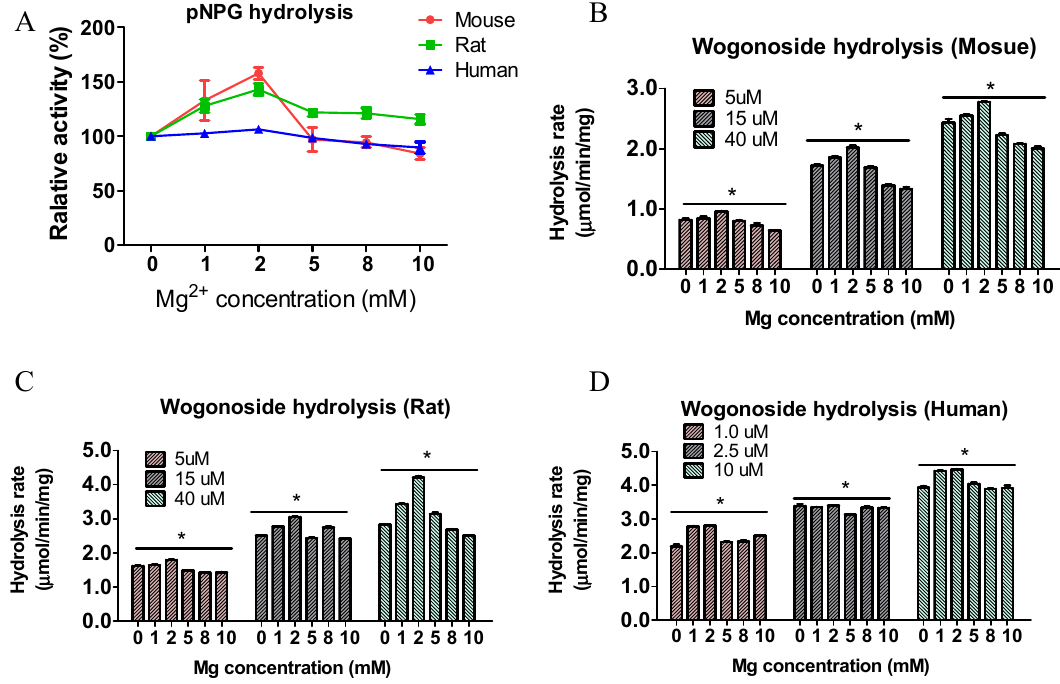
Figure 5. Impact of Mg 2+ on pNPG ( A ) and wogonoside hydrolysis ( B , mouse, C , Rat, D , Human). The pNPG (final concentration, 1 mM) or wogonoside was incubated with the enzymes in the buffers containing different concentrations of Mg 2+ for 30 min at 37 °C (n = 3, * p < 0.05, One-Way ANOVA). The results showed that Mg 2+ is not a critical co-factor for GUS enzyme.